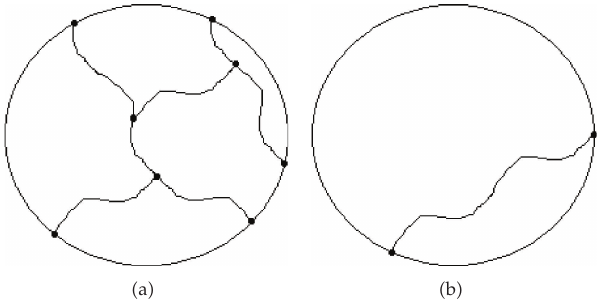
Figure 13: Feynman graphs in AdS. We did the one with two external legs in Section 4.3. Created by Francesco